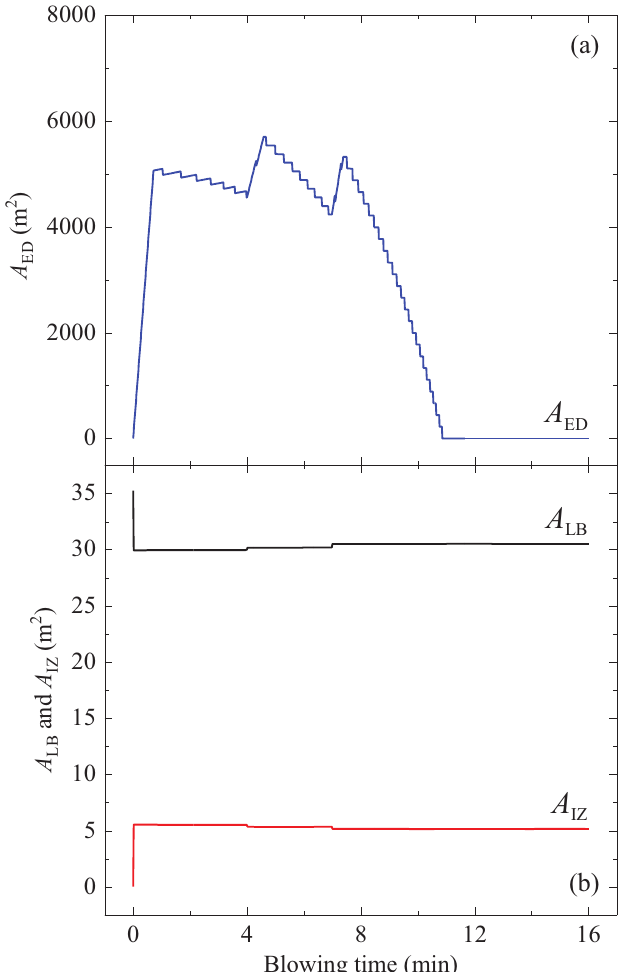
Figure 11. Area change during the oxygen blowing: ( a ) A ED ( t ) for the ejected droplets, ( b ) A IZ ( t ) for the impact zone in the liquid bath, and A LB ( t ) for the rest of the liquid